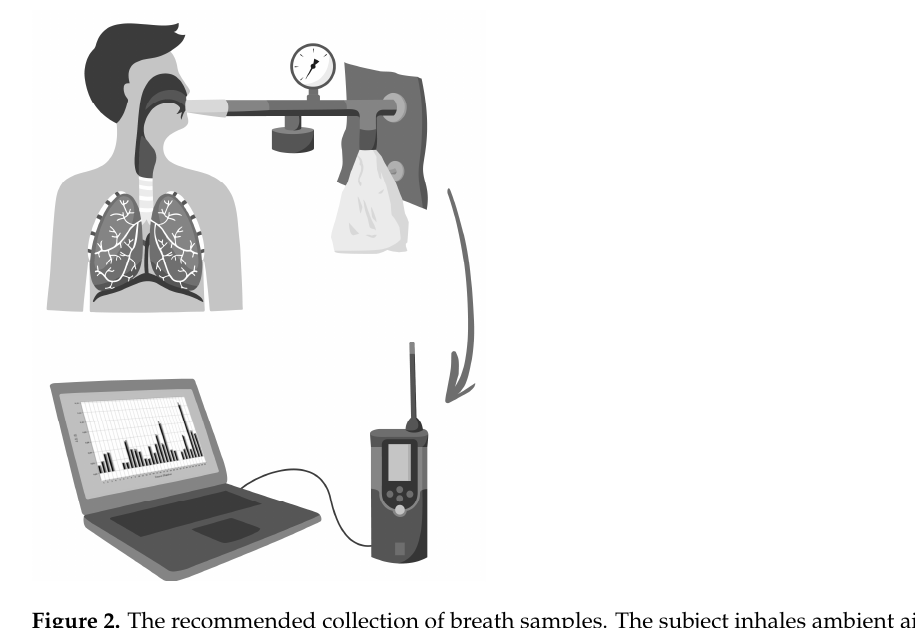
Figure 2. The recommended collection of breath samples. The subject inhales ambient air through a VOC filter, and exhales against a resistance at a controlled flow rate. The first fraction of exhaled air is collected in a separate bag to exclude dead space air from the sample. Sample is collected in a special collection bag and is analyzed with the electronic nose device.